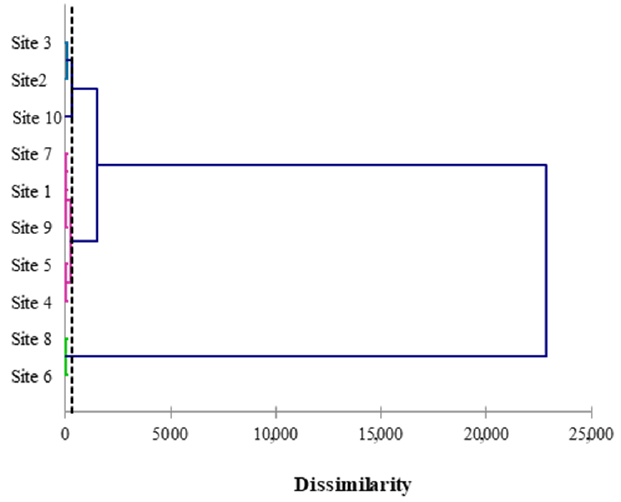
Figure 5. Dendrogram reporting the HCA statistical results.